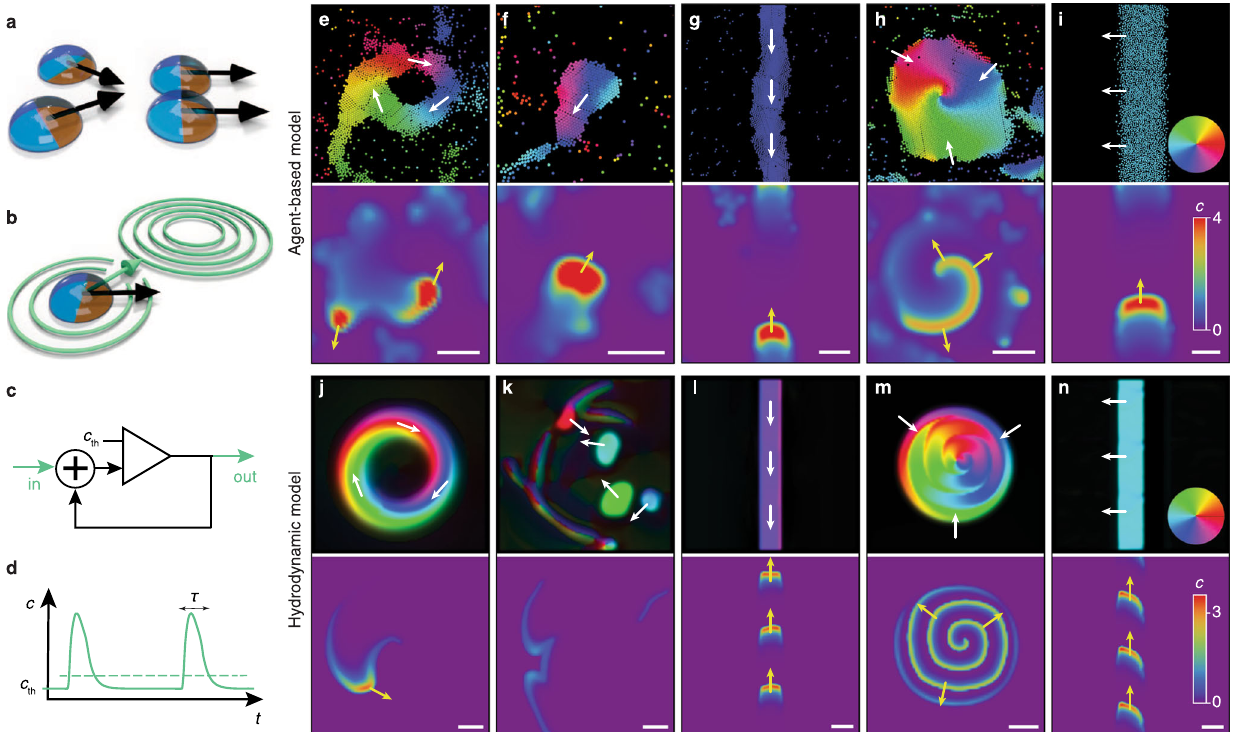
Fig. 1 | Schematics of the agent-based model for communicating active matter and summary of collective dynamic states. a Polar self-propelled particles undergoalignmentinbinarycollisions. b Adiffusiblesignal(green)alignsthecells ’ orientation vectors. c Schematic of a Schmitt trigger with variable threshold c th . d Temporal response c(t) of the agents ’ signaling system with characteristic